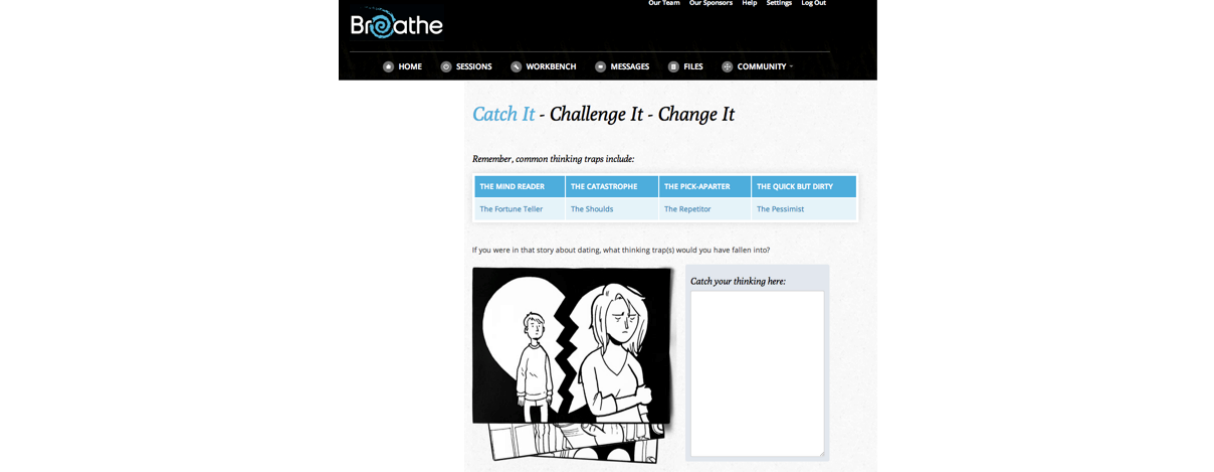
Figure 2. A screenshot of the Discover section within the Breathe